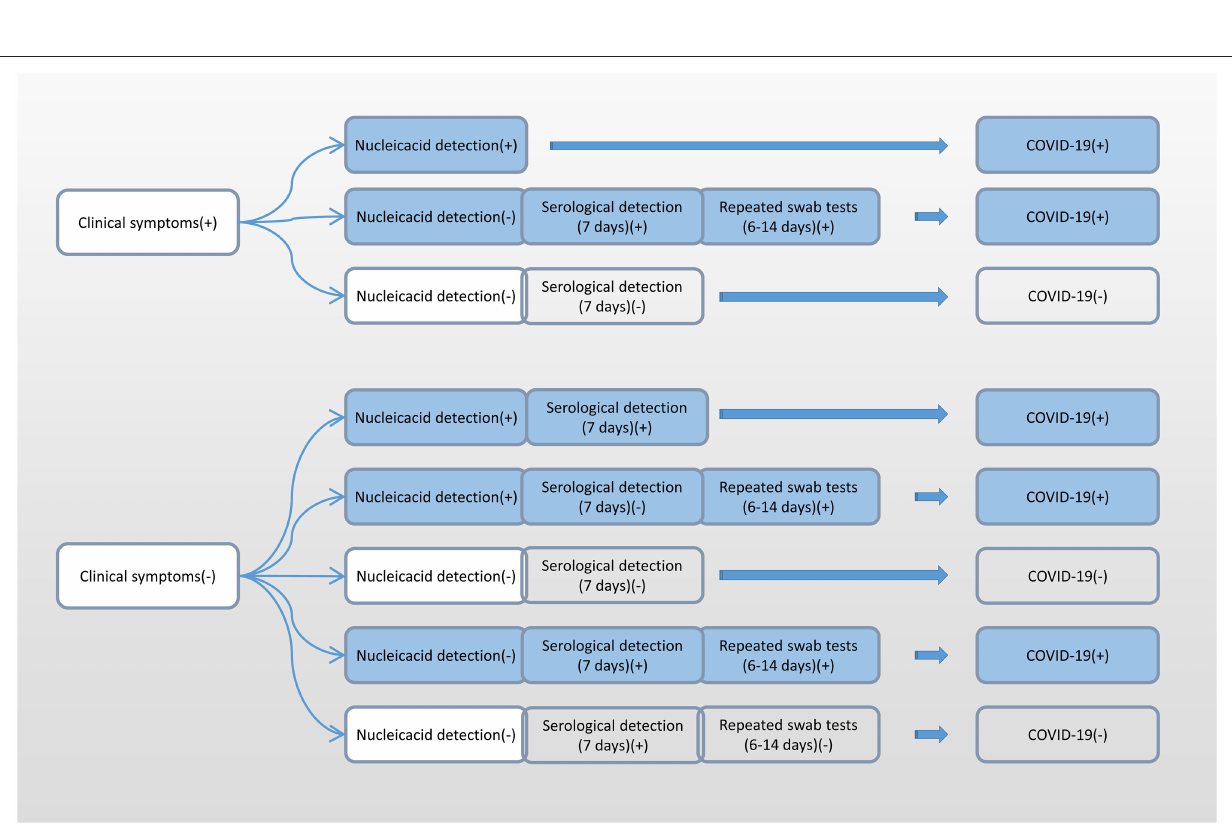
Frontiers in Public Health |